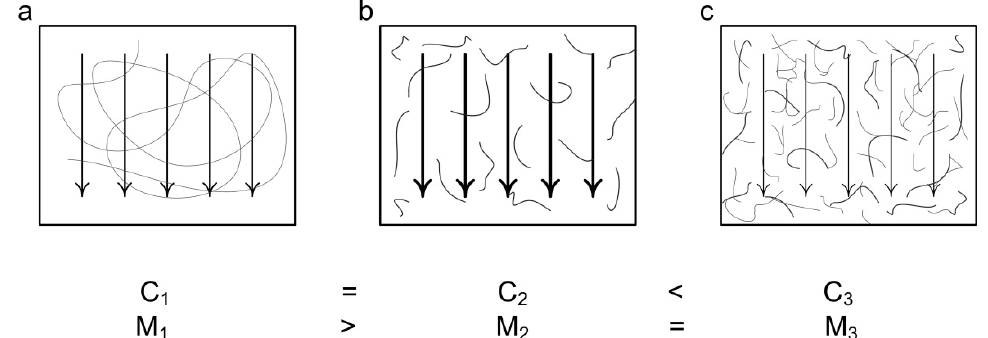
Figure 19. Stylized representation of the effect of various concentrations and molecular weight of hyaluronic acid on the floe conductivity. ( a ) C 1 = C 2 , M 1 > M 2 , ( b ) C 2 = C 1 , M 2 < M 1 , ( c ) C 3 > C 2 , M 3 = M 2 . Here C 1 , C 2 , and C 3 —hyaluronic acid concentrations, M 1 , M 2 , M 3 —molecular weight of hyaluronic acids. (Redrawn from [102]).